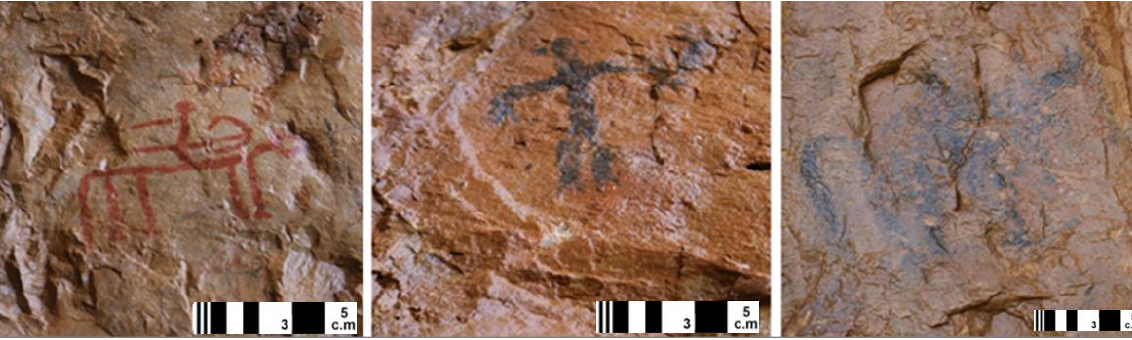
Figure 5. “Anthropomorphic” motif, “Horse rider” and foot in Shamsali Rock